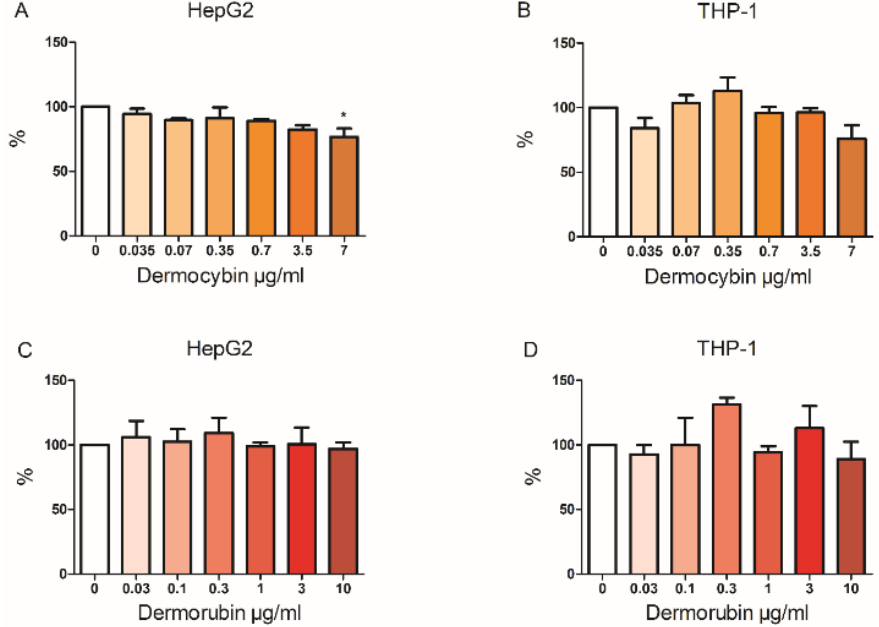
Figure 3. Cell viability measured with MTT after 24 h exposure to dermocybin and dermorubin. ( A ) and ( B ) represent dermocybin, ( C ) and ( D ) represent dermorubin. Data are shown as % of control ± SEM, * p < 0.05, n = 3.